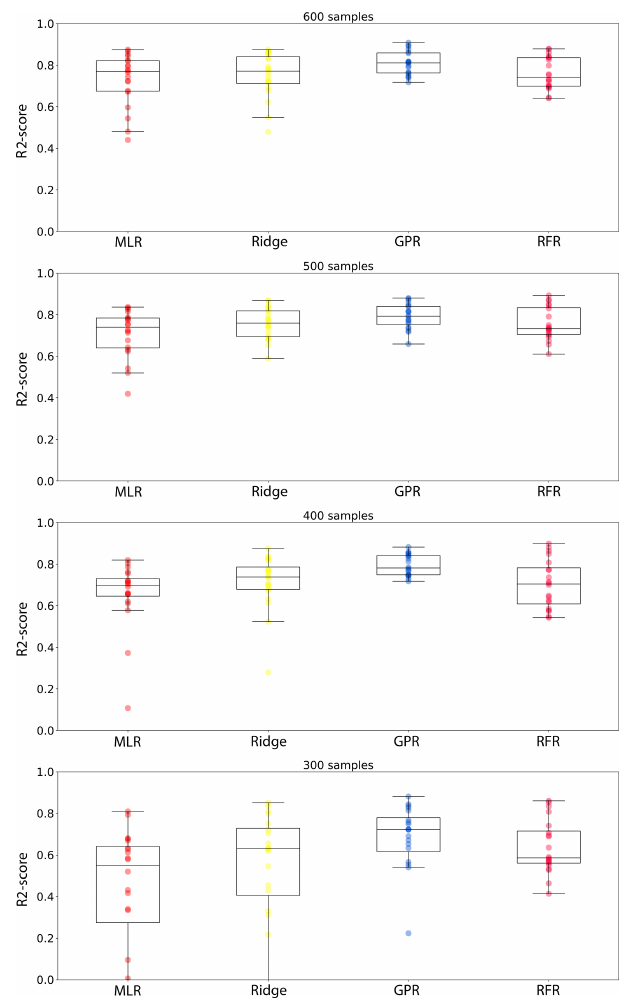
Figure 5. Node-specific I 30 R 2 scores depending on calibration method and training sample size, evaluated on consistent 220h test data sets in each case (see main text). The boxes extend from the lower to the upper quartile; inset lines mark the median. The whiskers extending from the box indicate the range excluding out- liers (fliers). Each circle represents the R 2 score on the test set for an individual node (21 in total). For MLR, some sensor nodes remain poorly calibrated even for larger sample